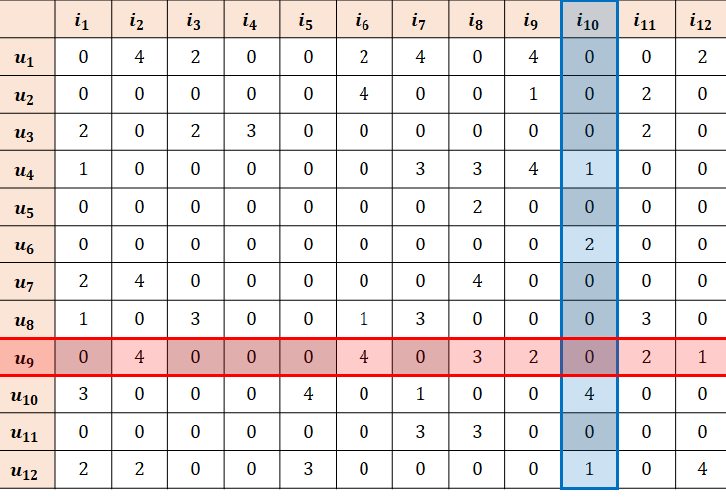
Figure 3. An example of missing data imputation of k-RRI.